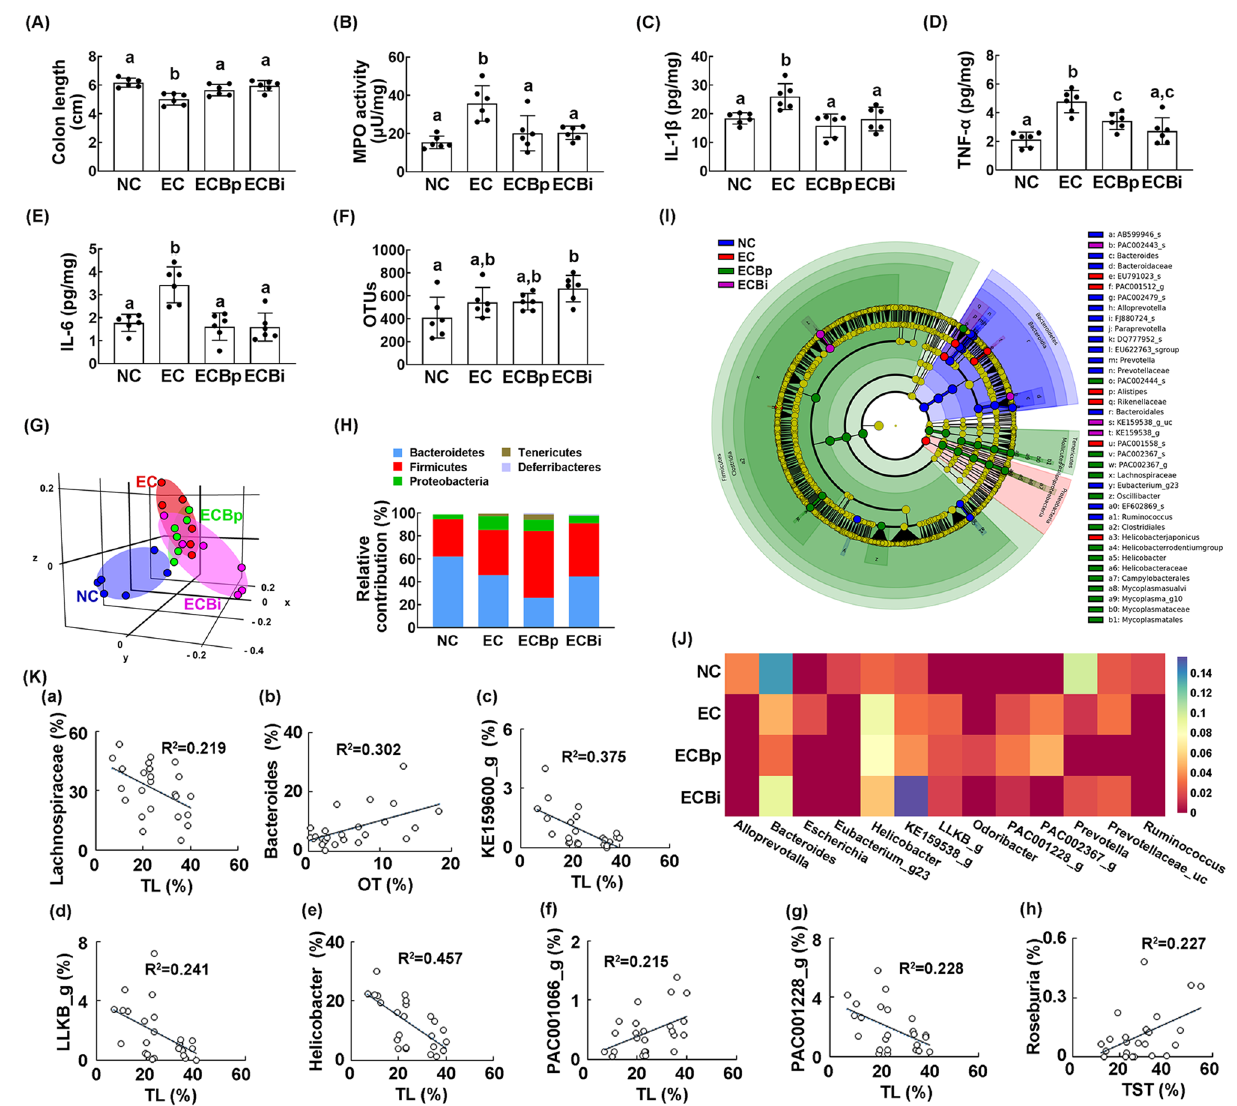
Figure 4. Orally gavage or intraperitoneal injection of buspirone alleviated Escherichia coli (EC)-induced colitis and gut microbiota pertubation in mice. Effects on IS-induced colon shortening ( A ), myeloperoxidase (MPO) activity ( B ), and IL-1β ( C ) and TNF-α ( D ) expression ( E ) in the colon. Effects on the composition of gut microbiota: OTUs ( F ), and principal coordinate analysis (PCoA) plot based on generalized UniFrac analysis ( G ). Composition of gut miciobiota were analyzed in phylum level ( H ). Cladogram was generated by LEfSE indicating ( I ) significant differences in gut microbial abundances among normal control (NC, blue), EC-treated (EC, red), orally buspirone-treated (ECBp, green), and intraperitoneally buspirone-treated (ECBi, purple) groups. ( J ) Effects on gut microbiota composition at the genus level, expressed as heat map. ( K ) The correlation between gut microbiota composition (a, family level; b–h, genus level) and anxiety-/depression-like behaviors, assessed in the EPM (time spent in the open arm [OT]), LDT (time spent in the light box [TL]), and TST (immobility time). Buspirone was orally gavaged (ECBp, 5 mg/kg/day) or intraperitoneally injected (ECBi, 1 mg/kg/day) daily for 5 days from the next day after the final exposure to EC. NC and NC (normal control mice) were orally treated with vehicle (saline) instead of buspirone. ( G ) and ( J ) were created in the free Plotly Make Chart program (https ://chart -studi o.plotl y.com/creat e/#/). ( I ) was created by using LEfSe analysis tool from the galaxy site (https ://hutte nhowe r.sph.harva rd.edu/galax y/). Data values were indicated as mean ± SD (n = 6). Same letters are not significantly different ( p <